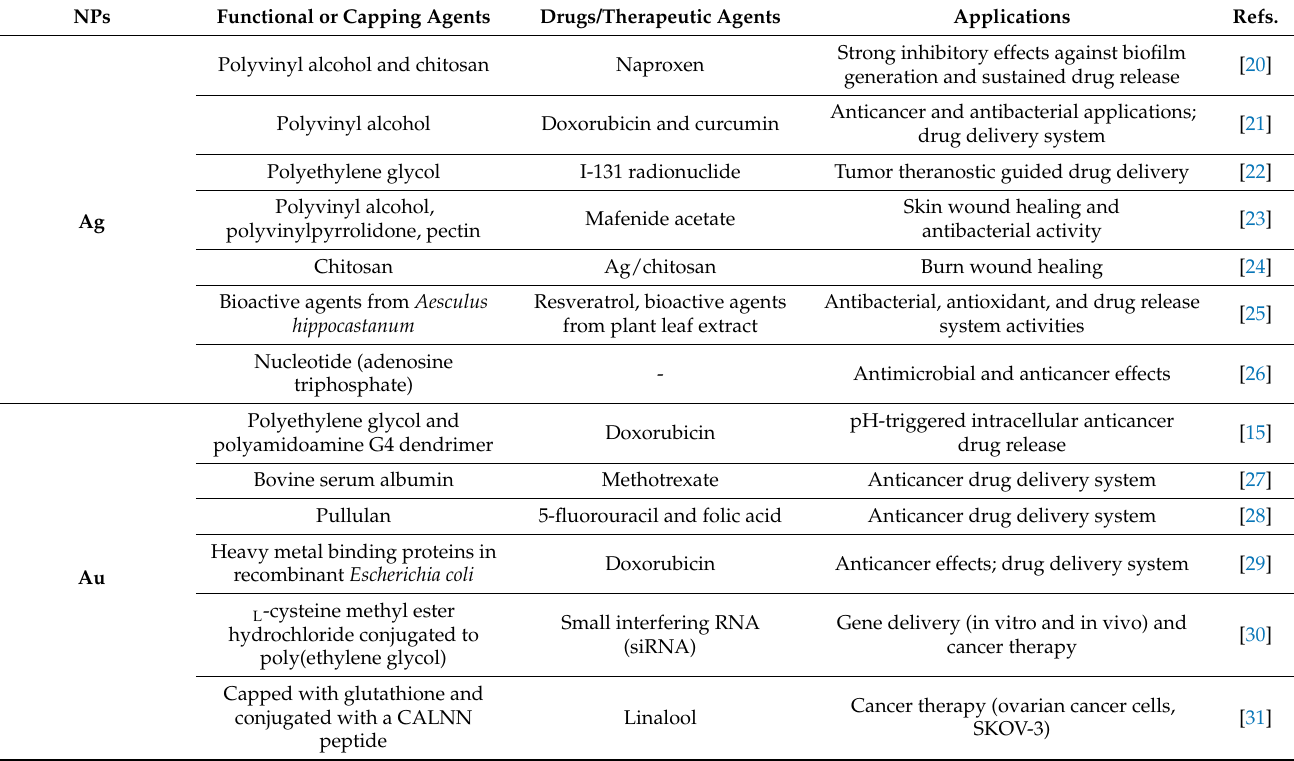
Table 1. Functionalized Ag and Au NPs with versatile diagnostic and therapeutic